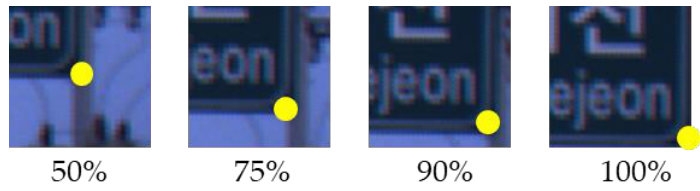
Figure A1. Side length ratio in the training corner patch.